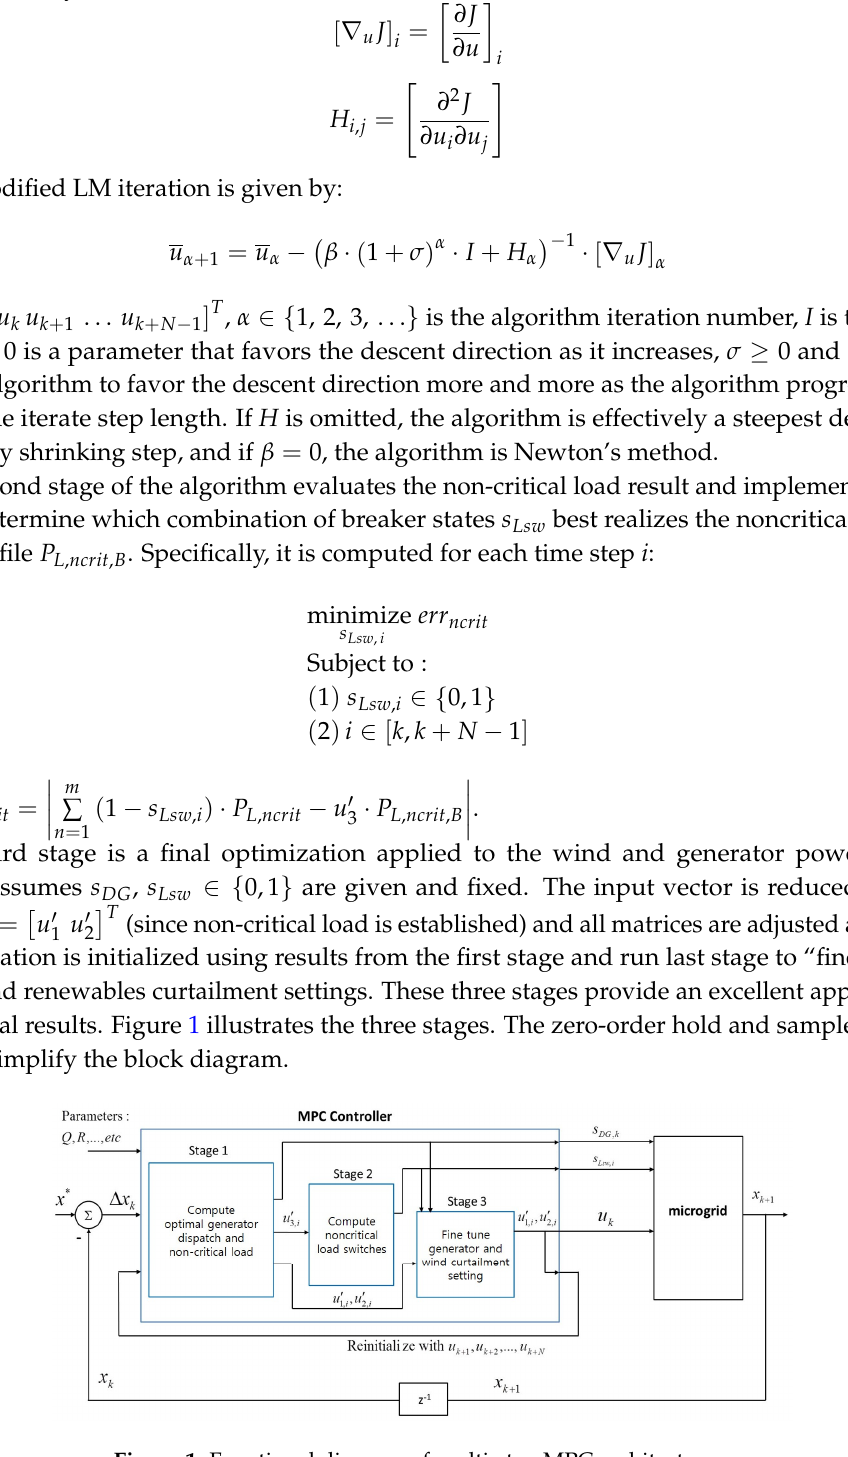
Figure 1. Functional diagram of multi-step MPC architecture.